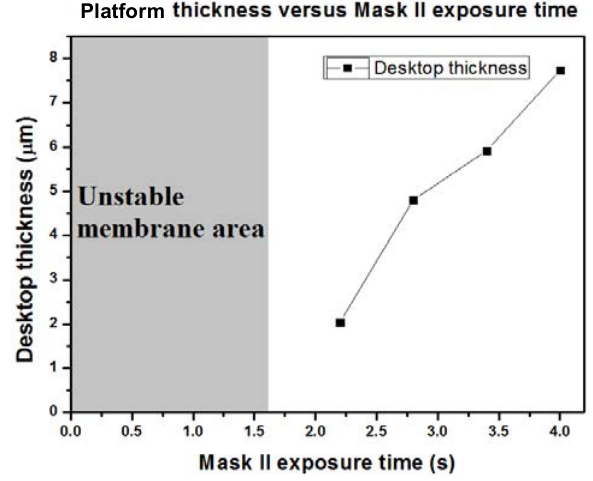
Figure 5. Scatter plot of platform thickness and mask II exposure